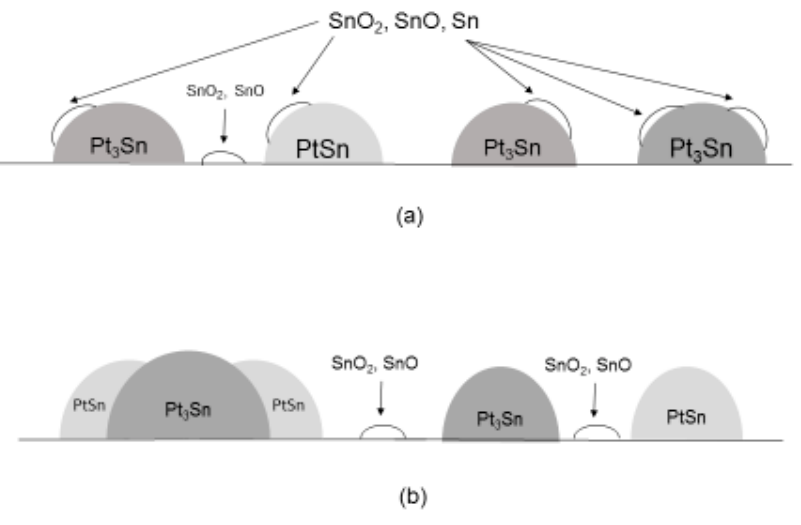
Figure 10. Hypothetical models of dispersed metals on Al 2 O 3 support. ( a ) Conceptual metal dispersion after direct-reduction for SR550 catalyst. ( b ) Conceptual metal dispersion for Cal600 catalyst.